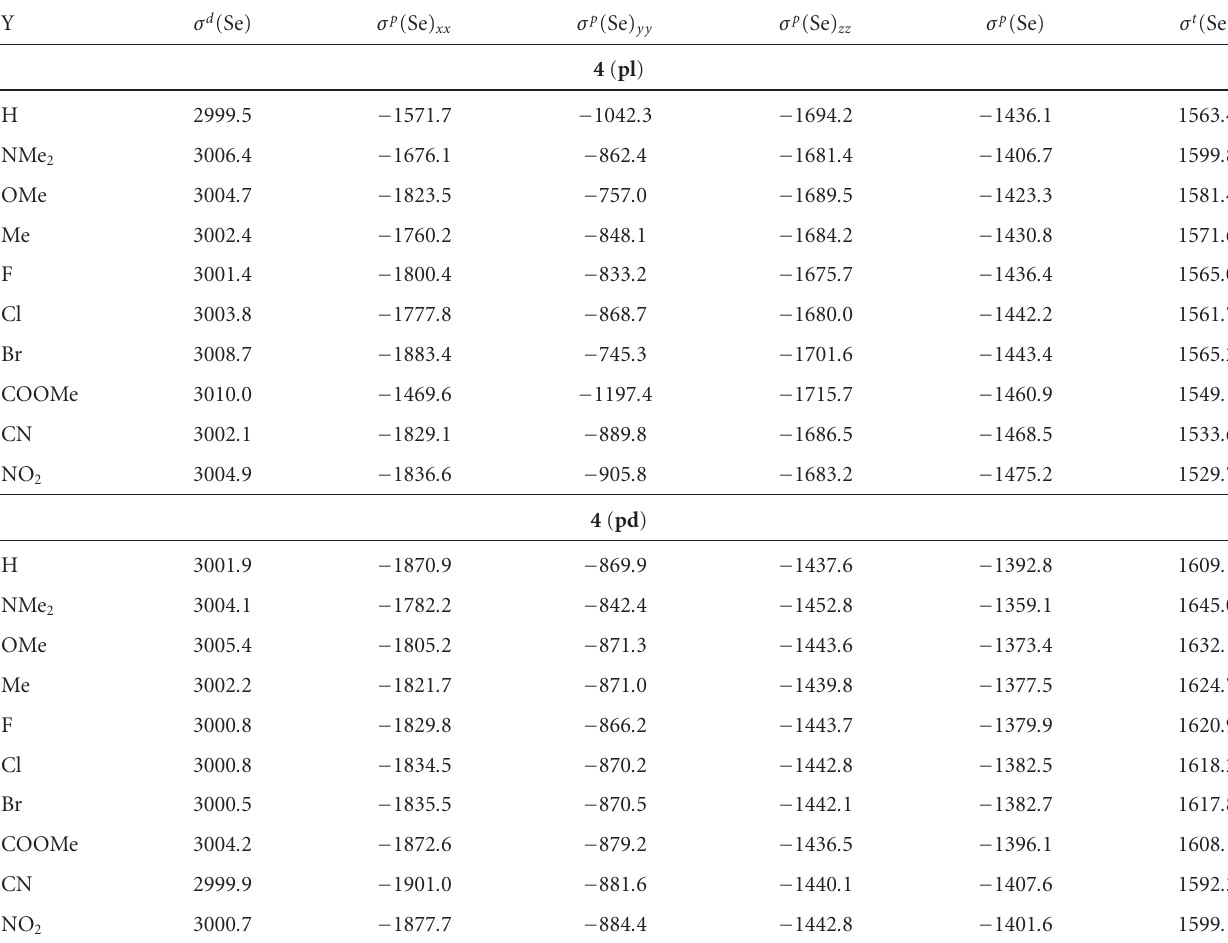
Table 3: Calculated absolute shielding tensors ( σ (Se)) of 4 , containing various Y (a) .